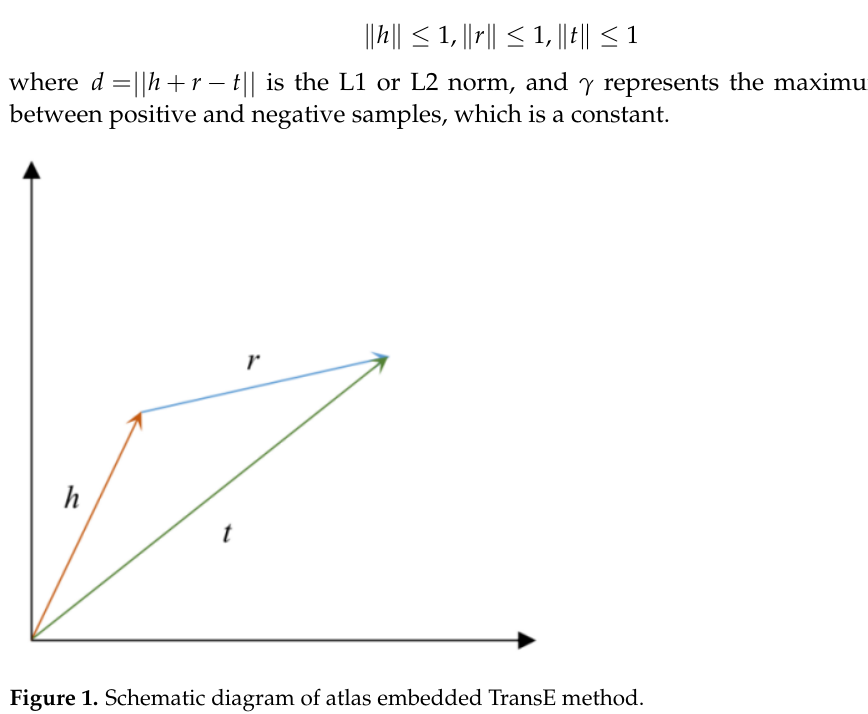
Figure 1. Schematic diagram of atlas embedded TransE method.